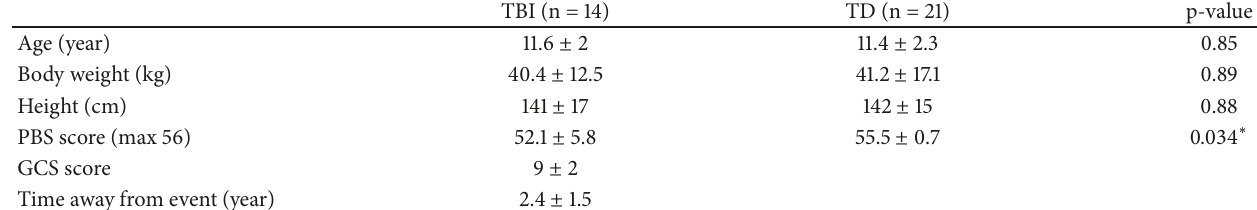
Table 1: Demographic information of children with TBI and TD children.